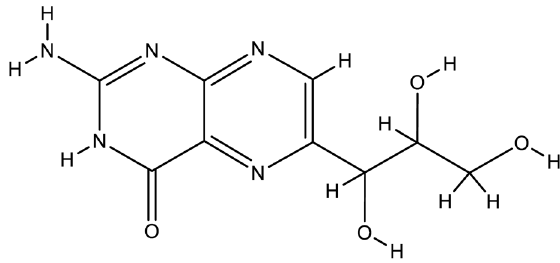
Figure 1. Chemical structure of